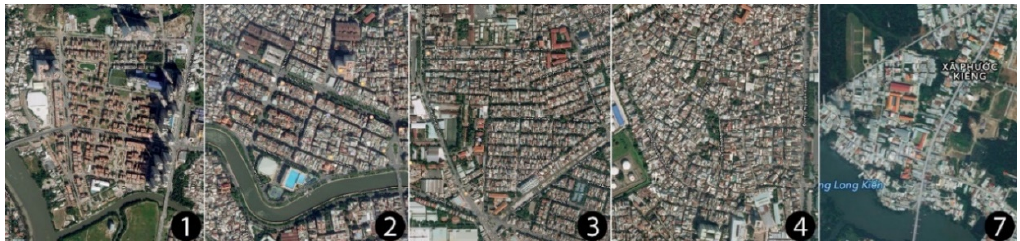
Figure 3. Proportions of urban housing pattern types in the research.